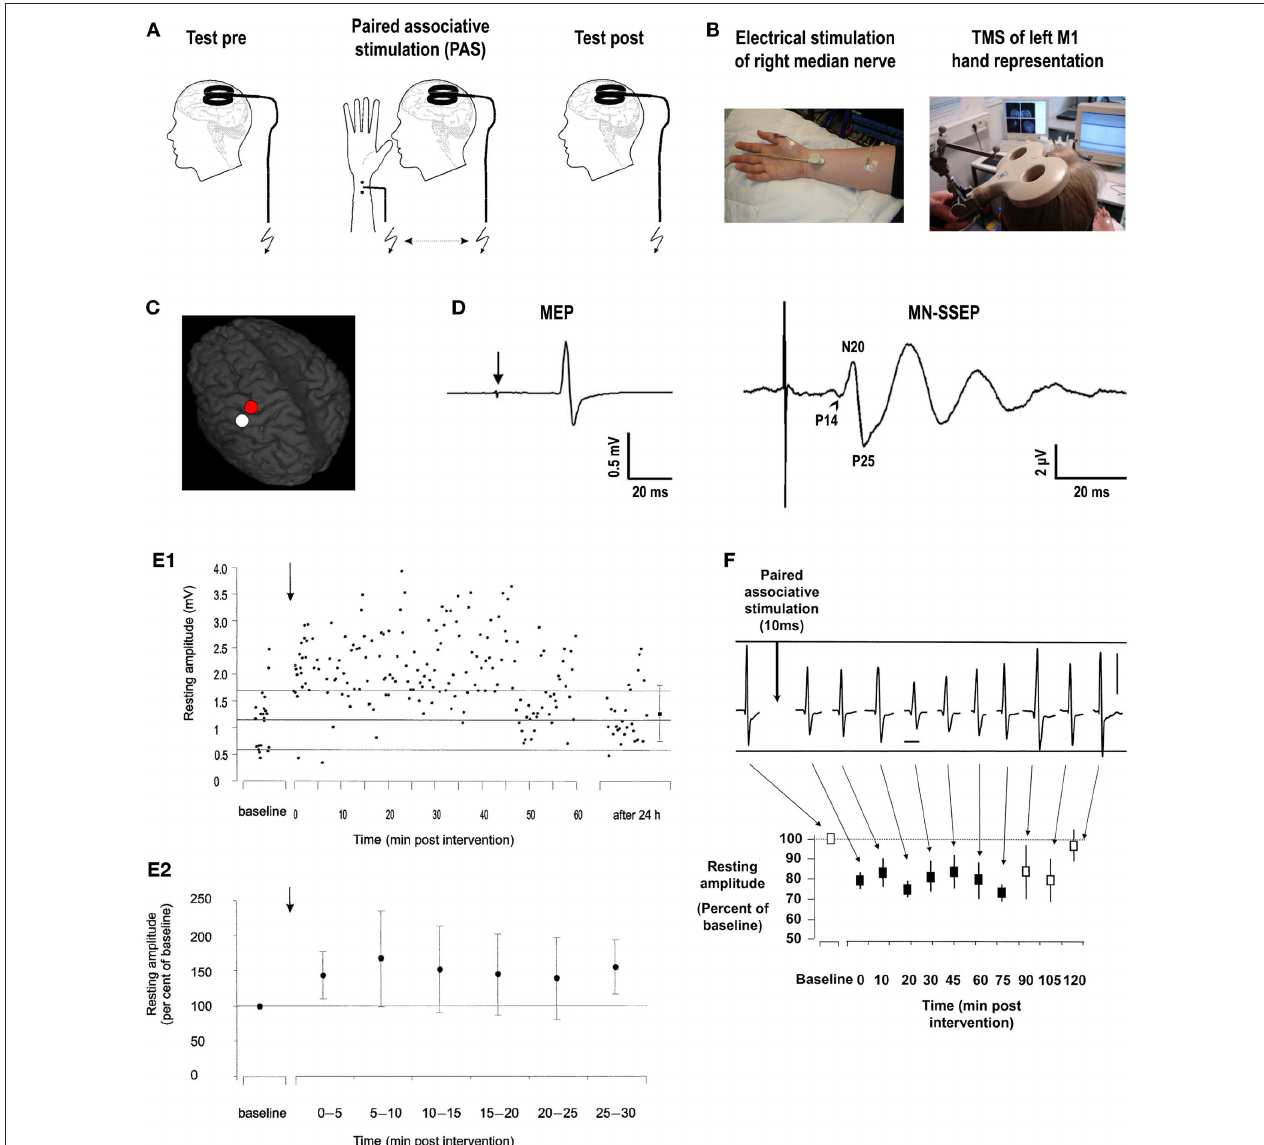
Figure 1 | Paired associative stimulation induces timing dependent plasticity in the human primary motor cortex. (A) Experimental design. Paired associative stimulation (PAS) consisted of electrical right median nerve stimulation (MNS) and transcranial magnetic stimulation (TMS) of the left primary motor cortex (M1) over the optimal site for eliciting motor evoked potentials (MEPs) in a muscle of the right hand ( M. abductor pollicis brevis , APB). Ninety pairs of stimuli were applied with a constant interstimulus interval (ISI) at a frequency of 0.05 Hz. Corticospinal excitability was probed before and after PAS by MEP amplitude in the right APB elicited by single-pulse TMS (adapted from Figure 1, Stefan et al., 2000. Permission pending). (B) Experimental setup (see text for explanations). (C) Stimulation site of TMS superimposed on a 3-dimensional structural MRI (red dot over left precentral gyrus). The white dot over the left postcentral gyrus indicates the primary somatosensory cortex (S1) hand representation. (D) Illustrative examples of MEP in the target muscle (APB) elicited by single-pulse TMS over M1 (red dot in B) at rest (left; arrow, time of TMS pulse delivery) and median nerve somatosensory-evoked potential (MN-SSEP) recorded from scalp electrodes overlying S1 (white dot in B ), respectively. P14, P14-potential (positive deflection ∼ 14 ms after MNS, arrowhead); N20, N20-potential (negative deflection ∼ 20 ms